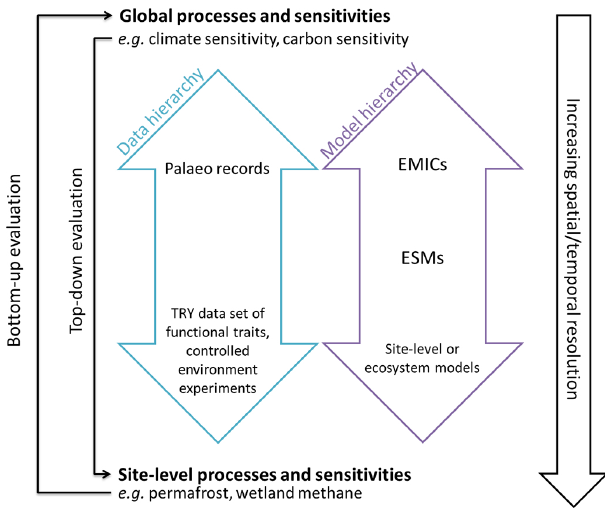
Fig. 1. Conceptual diagram of hierarchical approach to model eval- uation on different spatial and temporal